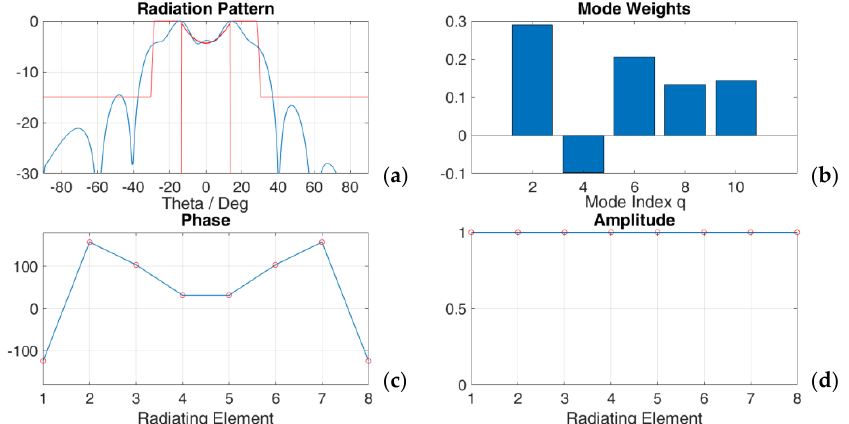
Figure 7. Phase-only synthesis with 8 radiating elements and 5 even Chebyshev basis functions. Element spacing is 0.65 λ 0 . ( a ) Radiation pattern; ( b ) Basis function weights; ( c ) Excitation phase; ( d ) Excitation amplitude.